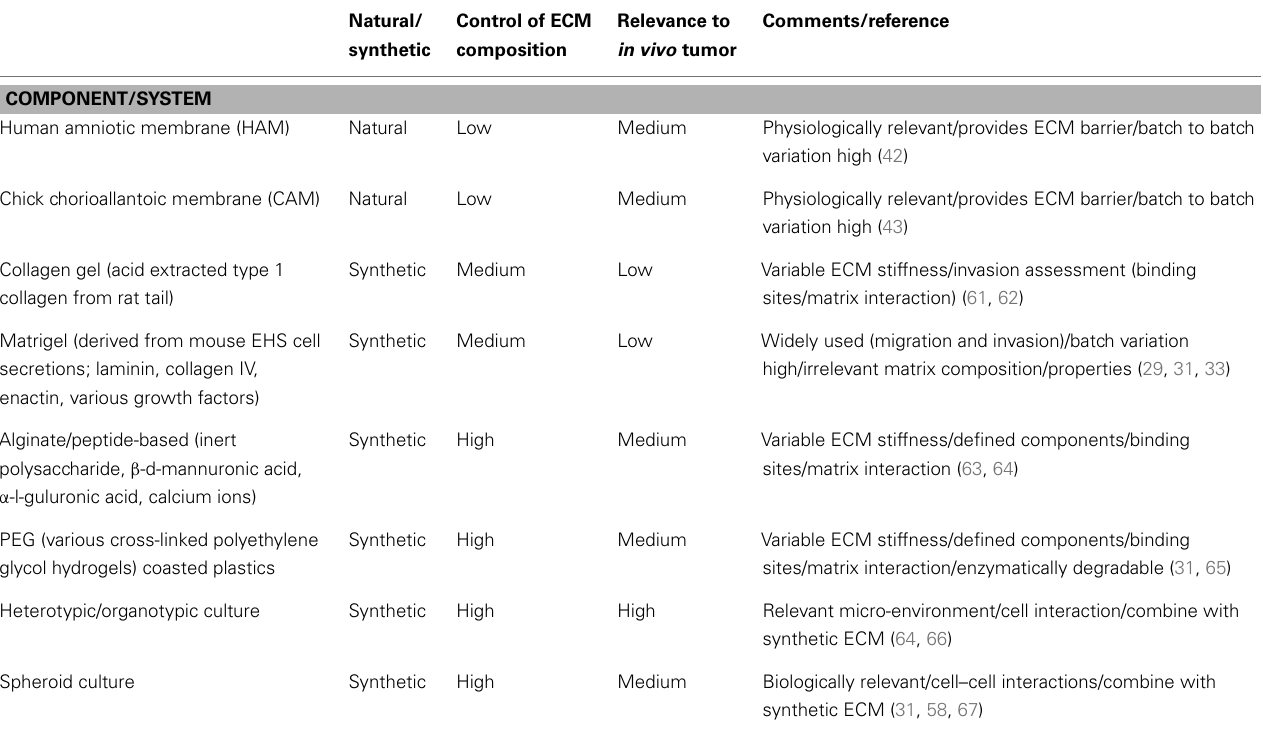
Table 1 | Summary of factors contributing to the choice of model system for ovarian cancer cell